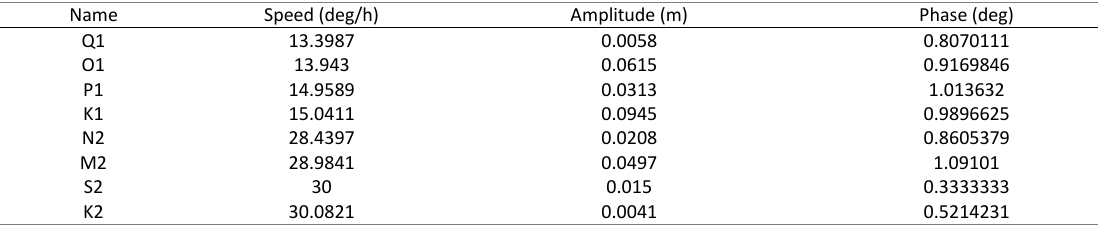
Table 2: Tidal constituents, amplitude and phase at Mallorquín-Sea mouth.